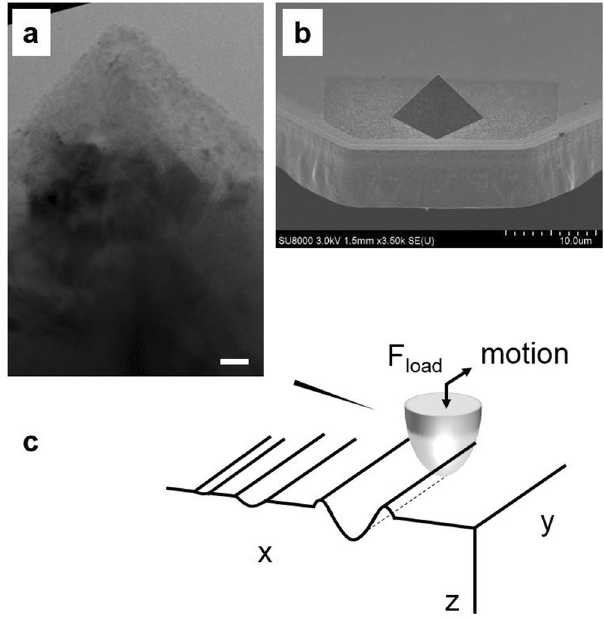
Figure 1. Details of the diamond tips used as sliding counterbody. ( a ) The apex of one of the diamond tips used in this work, as seen by high-resolution TEM (scale bar 20 nm). ( b ) The pyramidal shape of the tip is shown at lower magnification. ( c ) Schematic illustration of an AFM tip used to replicate a single-asperity sliding on a flat